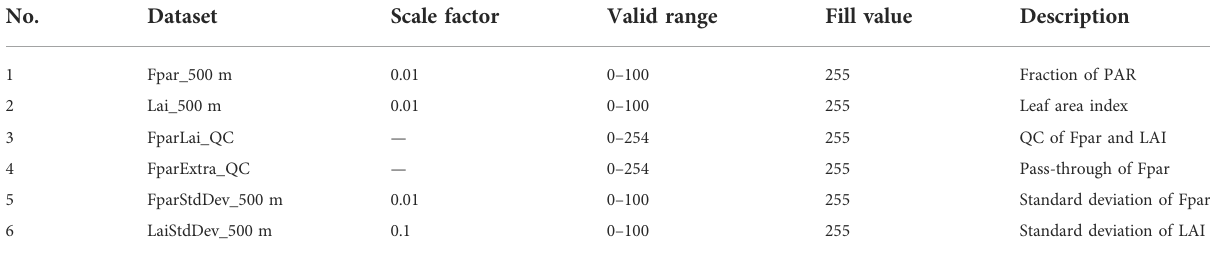
TABLE 1 Datasets of the MCD15A2H